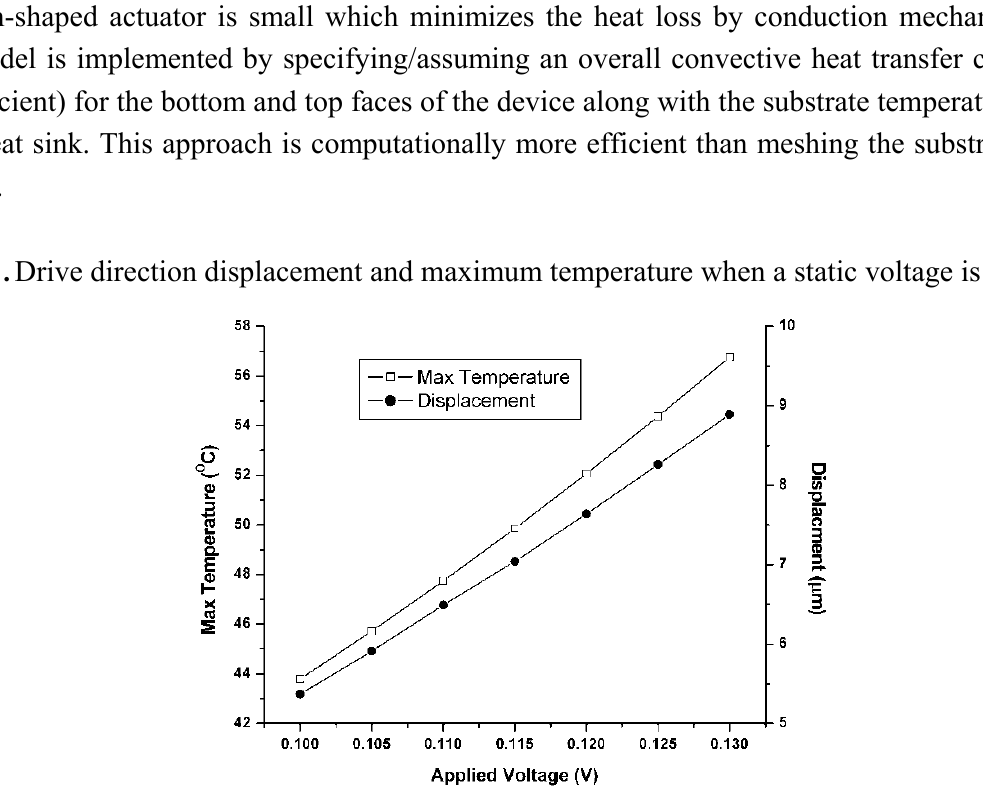
Predicted displacement vs. voltage and temperature vs. voltage plots are presented in Figure